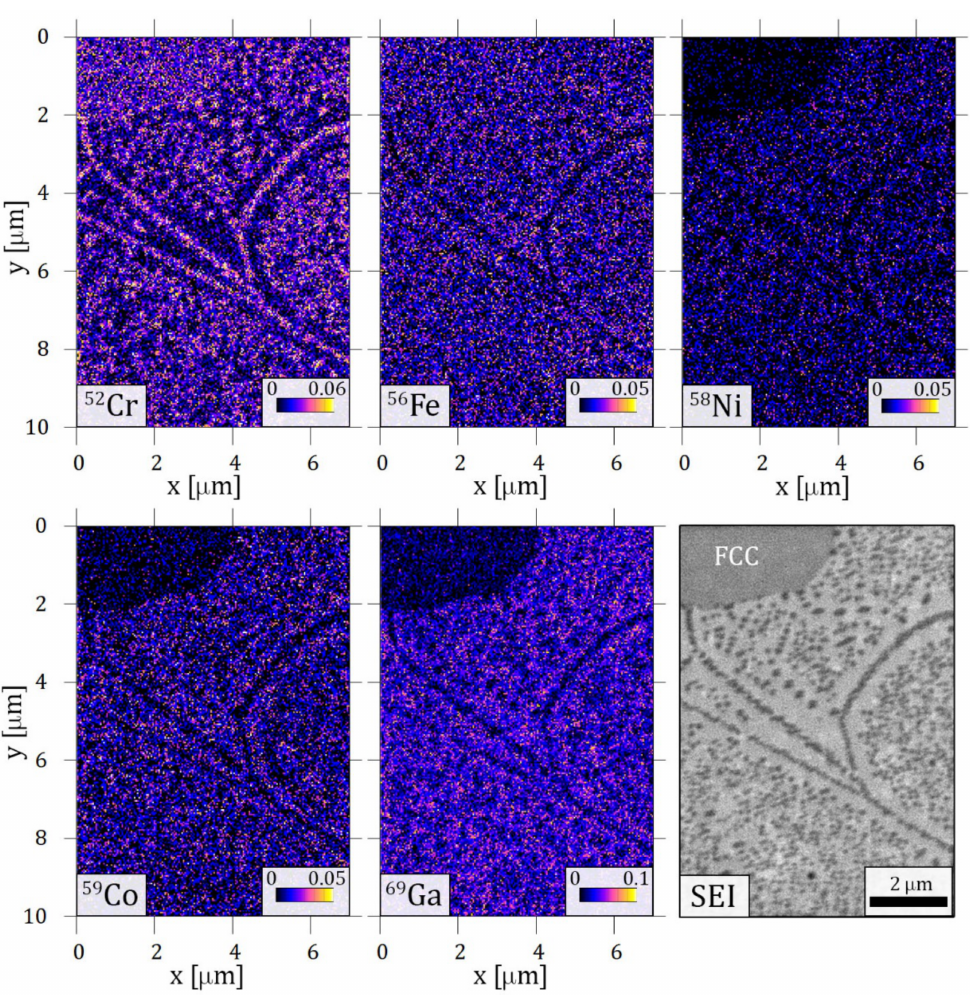
Figure 8. Elemental maps built from time-of-flight secondary ion mass spectroscopy (TOF-SIMS) results of the sample heat-treated at 1150 K for 1 h and slowly cooled. The area contains a phase boundary of BCC with cuboid structure and FCC phase (marked on the secondary electron image,